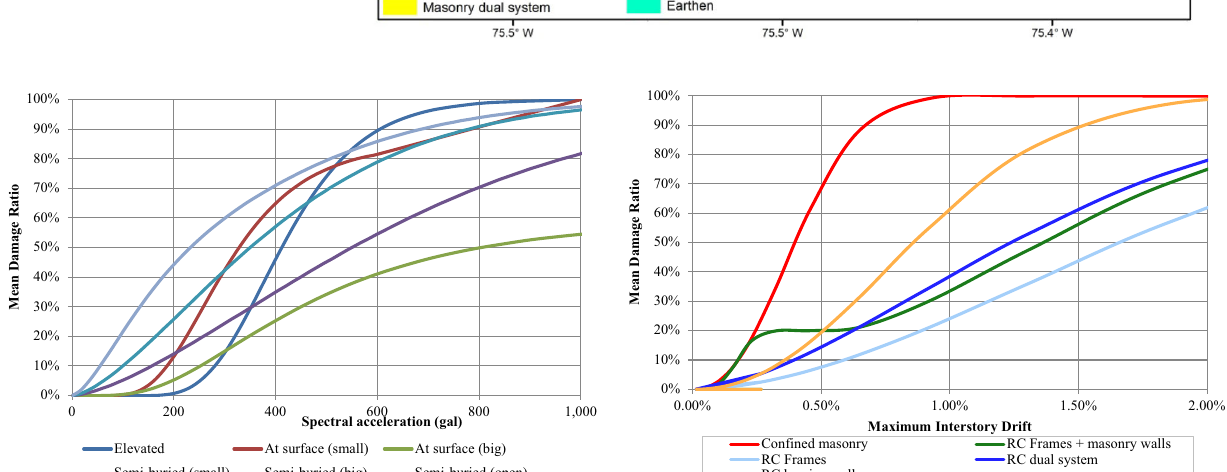
Fig. 2 Examples of some vulnerability functions for different types of water storage tanks ( left ) and for some of the different types of buildings ( right ) in Manizales,